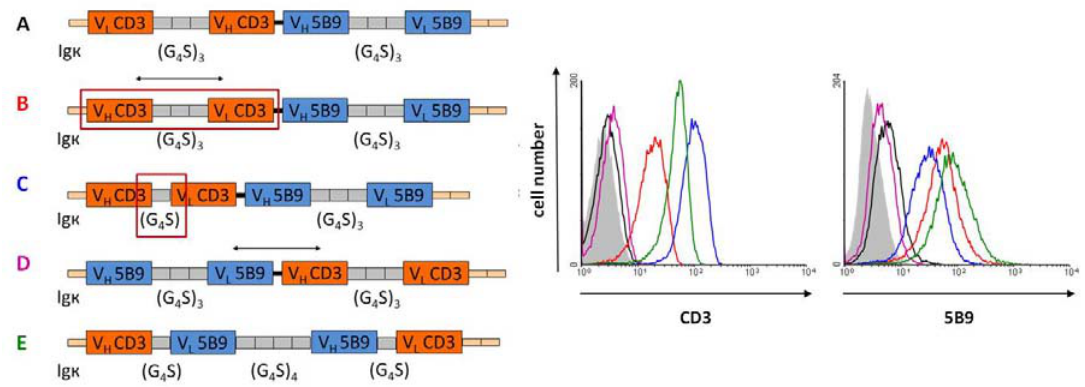
Figure 2. Effect of the heavy (V lengths on the binding capabilities of single-chain bispecific abs; G glycine and one serine residues as a peptide linker; Ig κ : leader